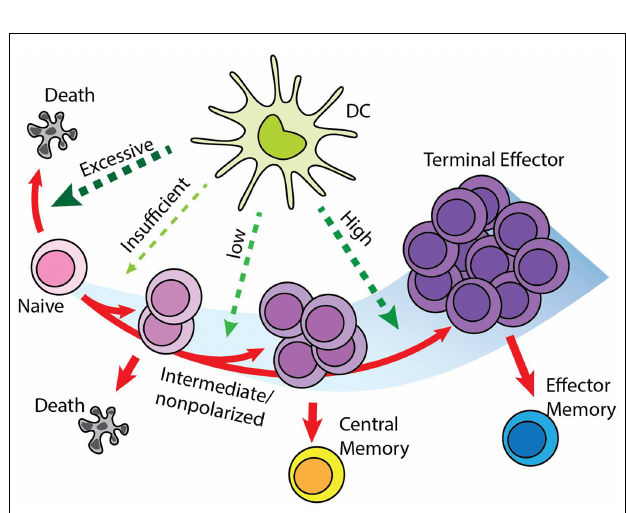
FIGURE 2 |T cell subsets in two-compartments of LNs and blood: N, naïve;A, activated; CM, central memory; E, effector; EM, effector memory . Each number indicates a collection of processes occurring in that step and in different cell types. NaïveT cells are recruited to LN from blood. In the LN, cognateT cells bind with Ag-DCs and get activated. ActivatedT cells proliferate and differentiate into central memory (CM)